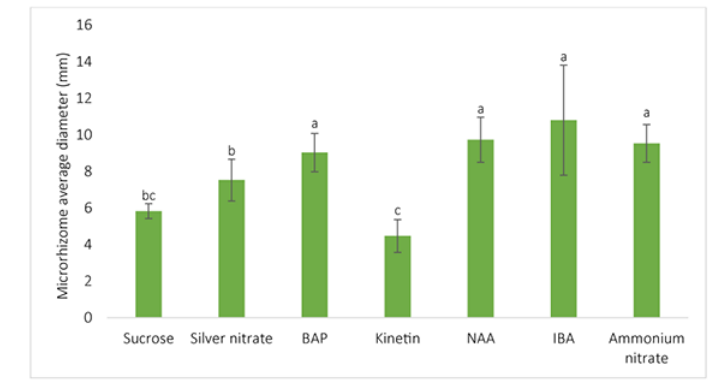
Figure 6 Maximum average diameter comparison among factors at their optimal concentrations being 80 g/L sucrose, 1.9 mg/L AgNO 3 , 4 mg/L BAP (6-benzylamino purine), 6 mg/L kinetin, 6 mg/L NAA ( α -naphthaleneacetic acid), 4 mg/L IBA (indole-3- butyric acid), and 550 mg/L NH 4 NO 3 . As is highlighted from the chart, there was no observed significant difference among the four maximum average diameters of 4 mg/L BAP, 6 mg/L NAA, 4 mg/L IBA, and 550 mg/L NH 4 NO 3 . This means that MS media supplemented with those four factors are the optimal culture media for the production of the largest ginger microrhizomes [the values shown in the bar charts are mean ± t (29) × SE , where t (29) is the upper 0.025 critical value for the t distribution with 29 degrees of freedom; means having a letter in common are not significantly different at the 5% level by Duncan’s test].